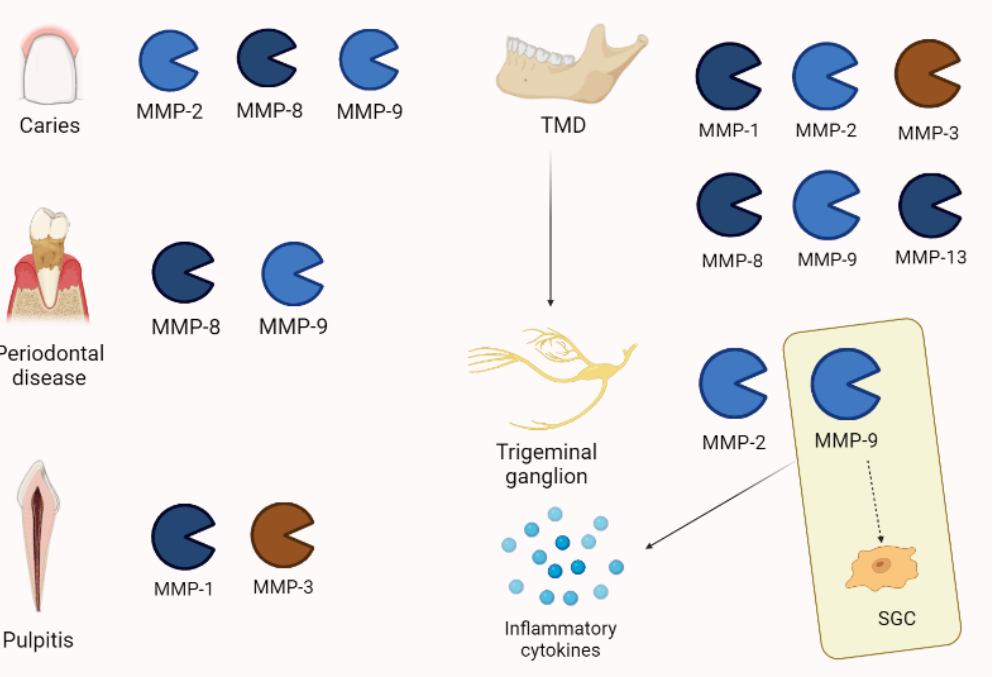
Figure 7. MMP expression in orofacial pain is different, depending on the pathology. Interestingly, in temporo-mandibular disease (TMD), MMP-2 and -9 are also increased in trigeminal ganglion. Moreover, MMP-9 is associated with pain persistency through its action on satellite glial cells (SGCs) and the activation of inflammatory